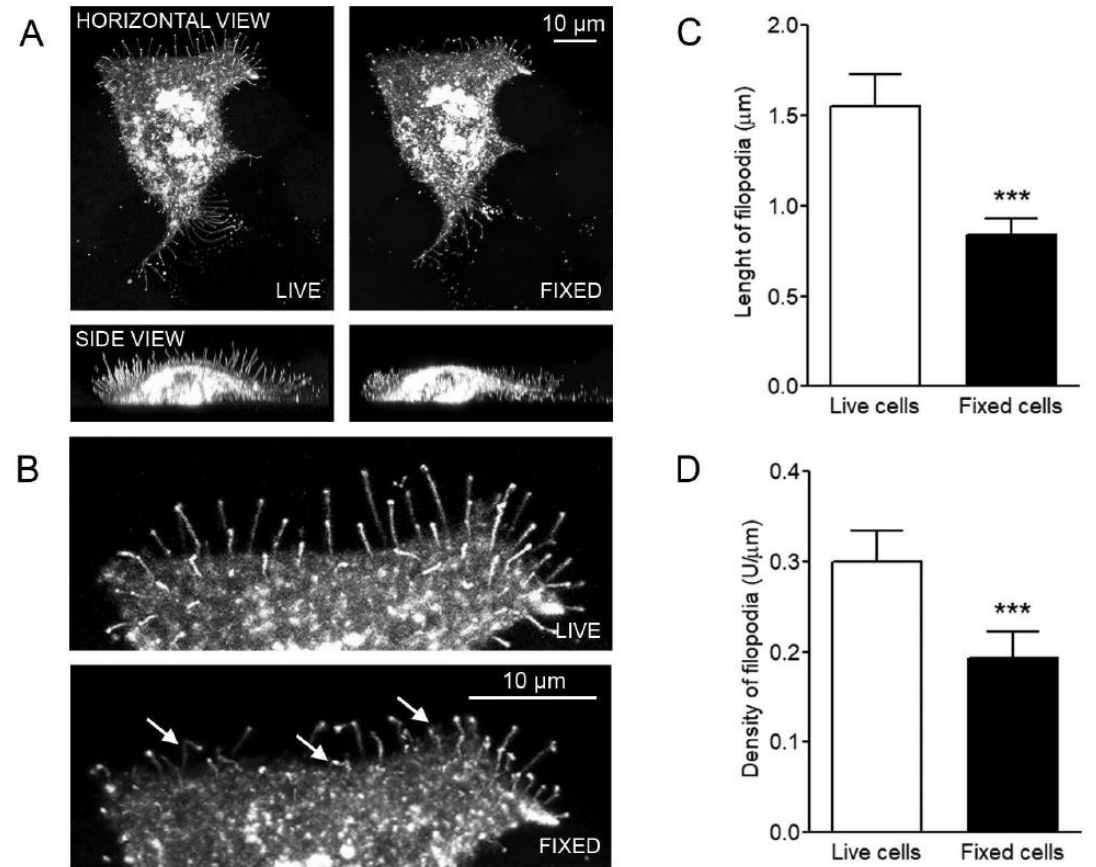
Figure 1. Numbers and length of filopodia are decreased after fixation. ( A ) The same GFP-hyaluronan synthase 3 (HAS3) expressing cell before (live) and after fixation with 4% paraformaldehyde (fixed). ( B ) A higher magnification from one edge of the cell. FiloQuant measurement of ( C ) filopodia length and ( D ) relative density in live and fixed cells ( n = 25 cells for both groups). *** p < 0.001. Unpaired t -test. Magnification bars = 10 µm.